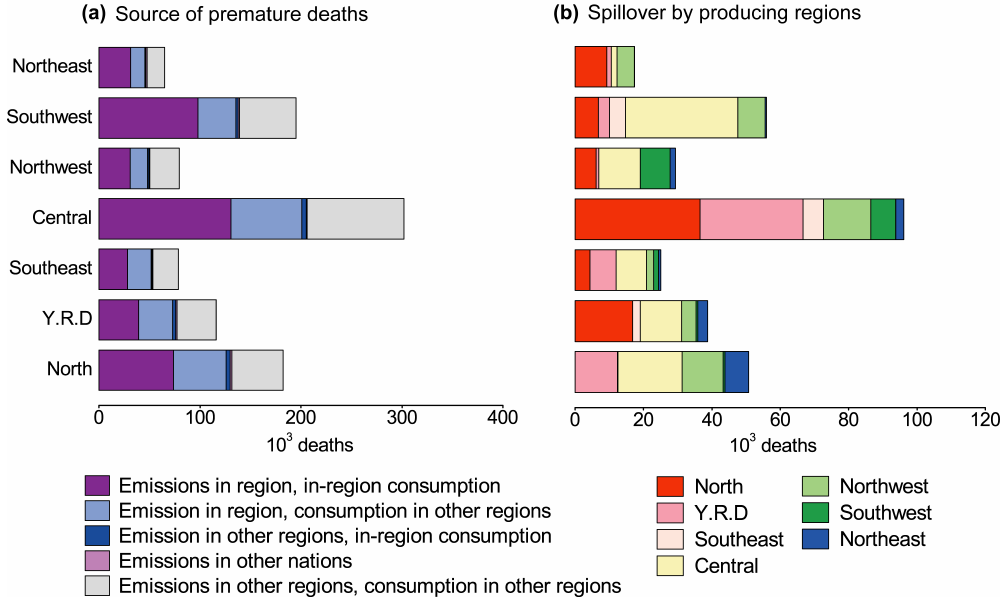
Figure 5. Source of PM 2 . 5 -related premature mortality in each region (a) and their “spillover” source by producing regions (b) (i.e., the gray bars in (a) : deaths due to emissions in other regions related to goods and services consumed in other